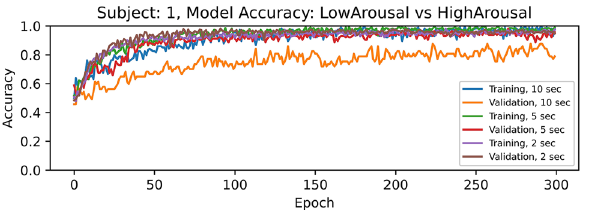
Figure 1. Accuracies for low arousal vs high arousal classification using segments of 10, 5, and 2 s from all the EEG channels of subject 1.